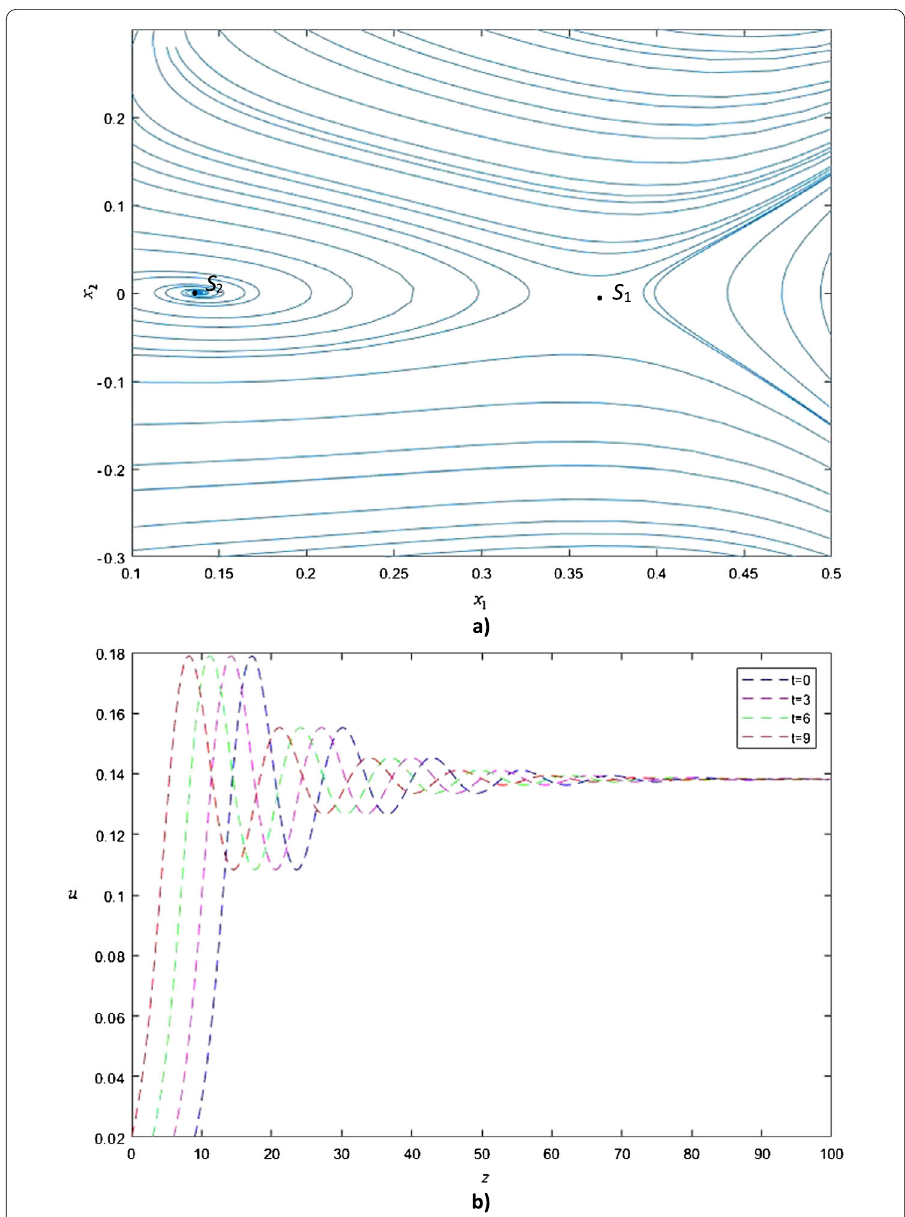
Figure 1 Phase portrait. ( a ) Plot of the phase portrait of the model system (7)–(8) showing solution trajectories in the vicinity of the two steady states, one of which is a saddle point and the other a stable focus as predicted by Theorem 1. Here, S 1 is the steady state ( u 1 ,0) and S 2 is ( u 2 ,0). ( b ) Plot of fish population density u as a function of traveling wave coordinate for t between 0 and 9. Here, a = 1 , m = 1, τ = 2, v = 1 , and w = k = 1 2 2